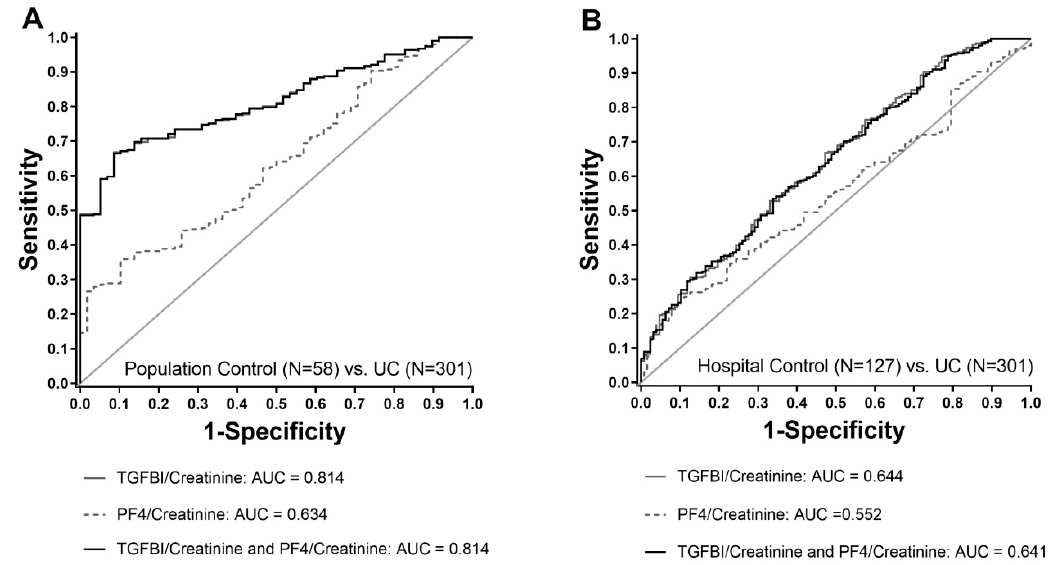
Figure 3. Receiving operator characteristic (ROC) curves of urinary TGFBI and PF4 alone and in combination. UC patients were compared with samples of the general population ( A ) and urologic controls from the hospital ( B ). For both curves, TGFBI alone and in combination with PF4, are nearly identical.